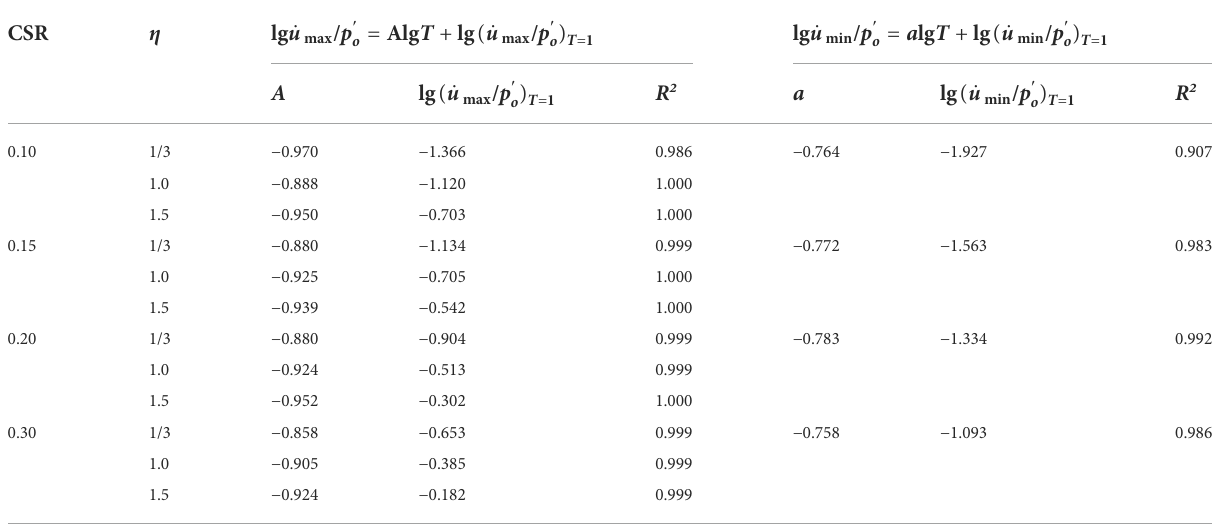
TABLE 4 Fitting parameters of Eqs 4,